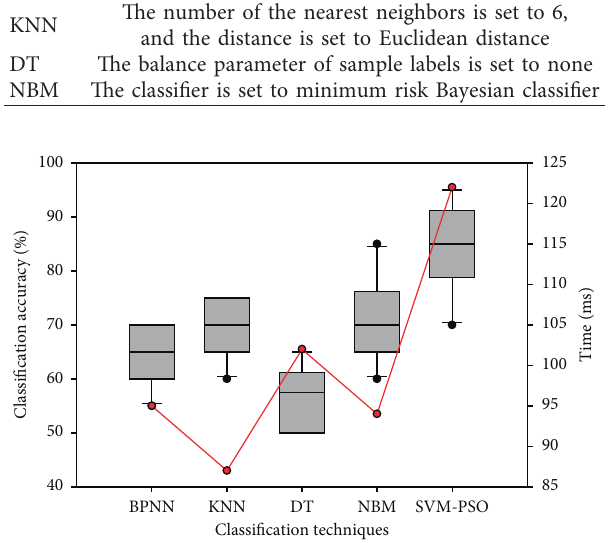
Figure 14: Classification results using different classification